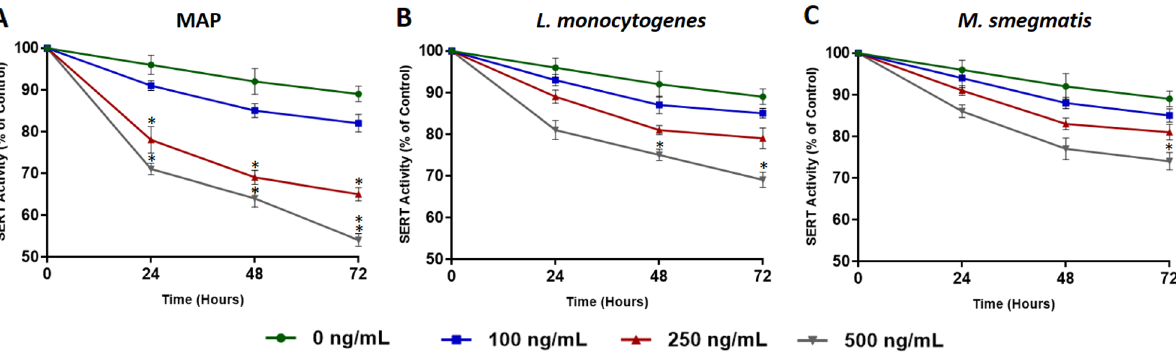
Figure 2. Effects of MAP ( A ), L. monocytogenes ( B ) and M. smegmatis ( C ) infections on SERT activity in fully differentiated Caco-2 monolayers in the presence of different levels of 5-HT (0, 100, 250, and 500 ng/mL) over 24, 48 and 72 h. Values are presented as percentage activity of control group without infection or 5-HT treatment. Values were pre-tested for normal distribution using the Kolmogorov–Smirnov normality test. Significance among experiments was assessed by repeated measures analysis of variance (ANOVA) followed by Bonferroni correction test. All SERT activity experiments were performed in triplicates using the homogeneous neurotransmitter transporter uptake assay (Molecular Devices Corporation, San Jose, CA). Data are presented as Mean ± SD. * P value < were infected with MAP, L. monocytogenes and M. smegmatis in the presence of different levels of 5-HT (0, 100, 250, 500 ng/mL). SERT activity was measured at three time points every 24 h and values were normalized to control group without infection or 5-HT exposure. We noticed that MAP infection had the greatest significant effect on reducing SERT activity when cells were exposed to 250 ng/mL (78.3 ± 3.2%, 69.5 ± 1.7% and 65.2 ± 1.4% at 24, 48 and 72 h, respectively) and 500 ng/mL (71.4 ± 1.5%, 64.3 ± 2.1% and 54.7 ± 1.5% at 24, 48 and 72 h, respectively) of 5-HT (Fig. 2A). Caco-2 monolayers infected with L. monocytogenes showed significant reduc- tion of SERT activity when cells were exposed to 500 ng/mL for 48 and 72 h (75.3 ± 1.6% and 69.8 ± 1.8% at 48 and 72 h, respectively) (Fig. 2B). However, M. smegmatis infection did not have a significant effect on SERT activity (Fig. 2C).